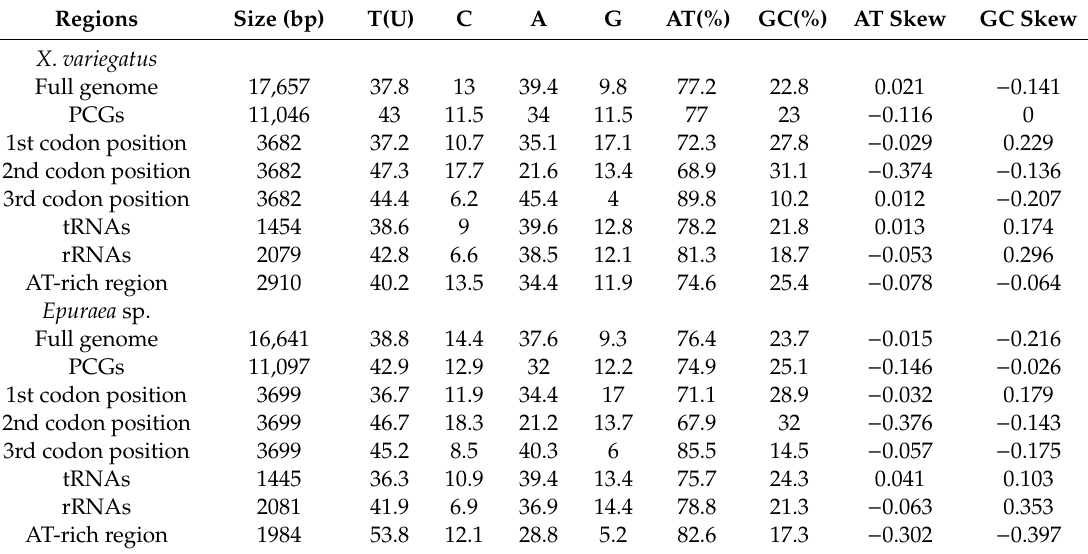
Table 2. Nucleotide composition of mitogenomes of X. variegatus and Epuraea